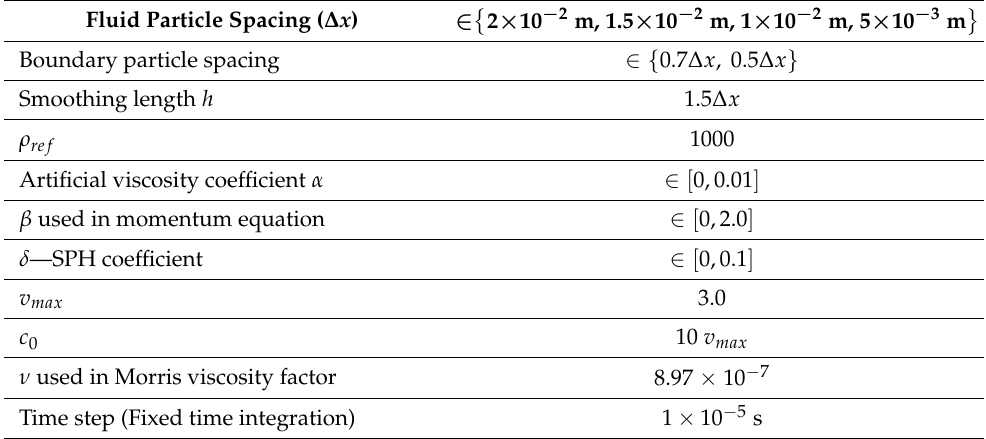
Table 4. Parameters and the numerical setting used for the numerical wave tank conditions. Fluid Particle Spacing ( ∆ x